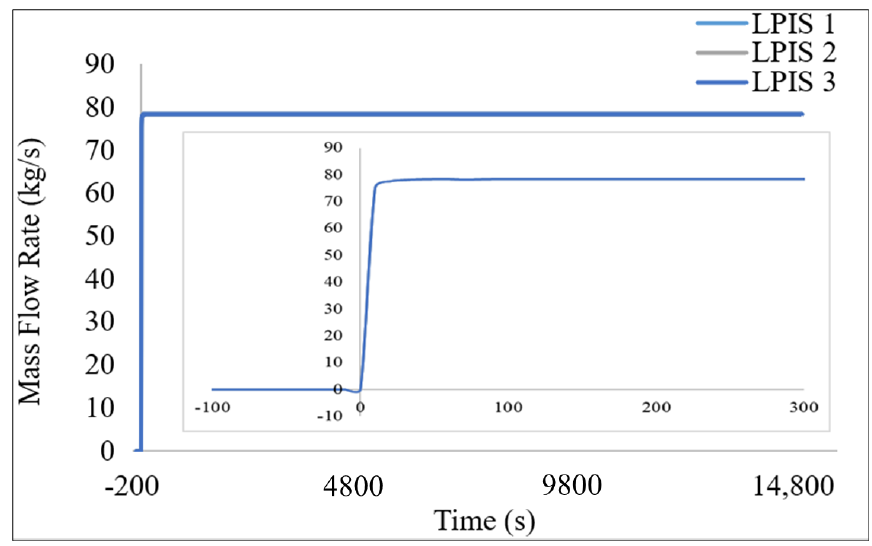
Figure 10. Injection of coolant from LPIS.